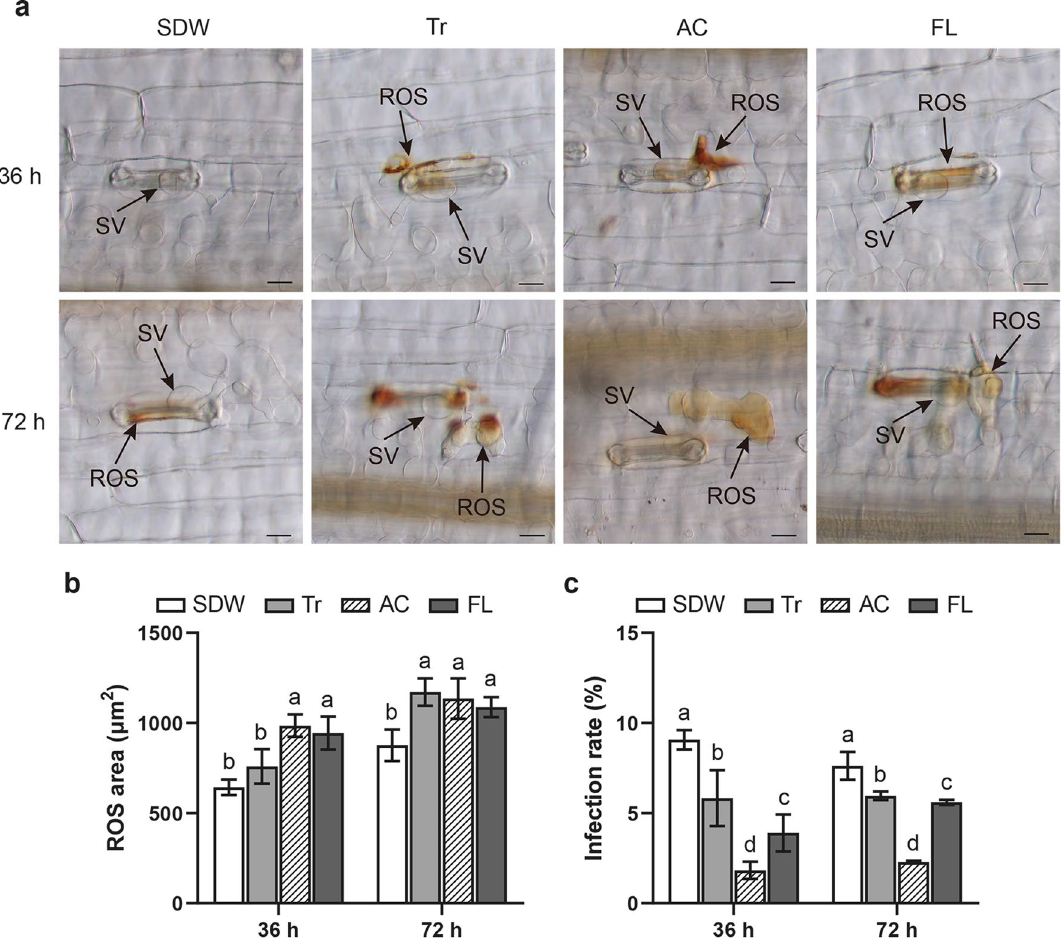
Fig. 4 Effects of XF treatments on ROS production and infection rate of Pst on wheat leaves. a Histological observation of H 2 O 2 accumulation after DAB staining in wheat leaves. SV, substomatal vesicle. Bars 20 μm. b , c The ROS area of wheat leaves ( b ) and the infection rate of Pst ( c ) in = the various treatment groups. Only infection sites where substomatal vesicles had formed over stomata were considered successful infections and were microscopically observed for the presence or absence of haustoria. The infection rate was calculated as the number of penetration sites that exhibited one or multiple haustoria in relation to the total number of stomata. Values in the chart are mean SD. By Duncan’s new multiple range ± tests, different lowercase letters indicate differences with significance level